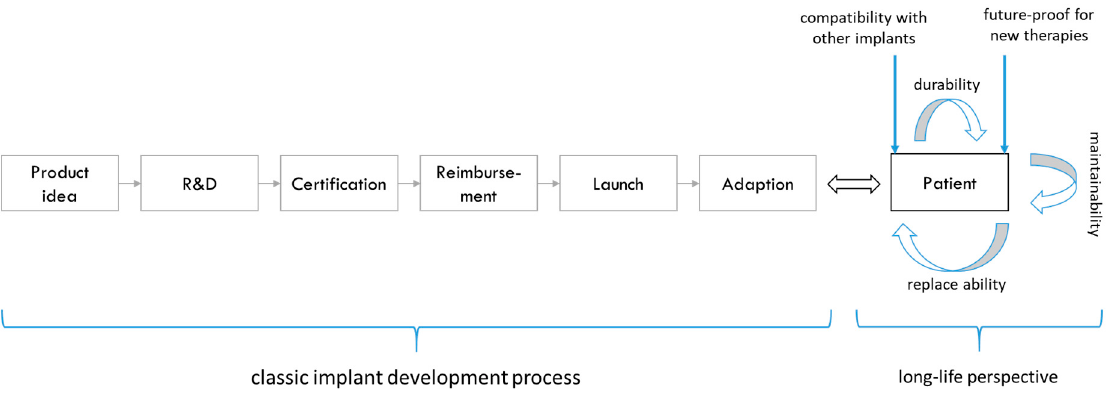
Figure 10. Modified implant development process with long-life perspective. Source own .